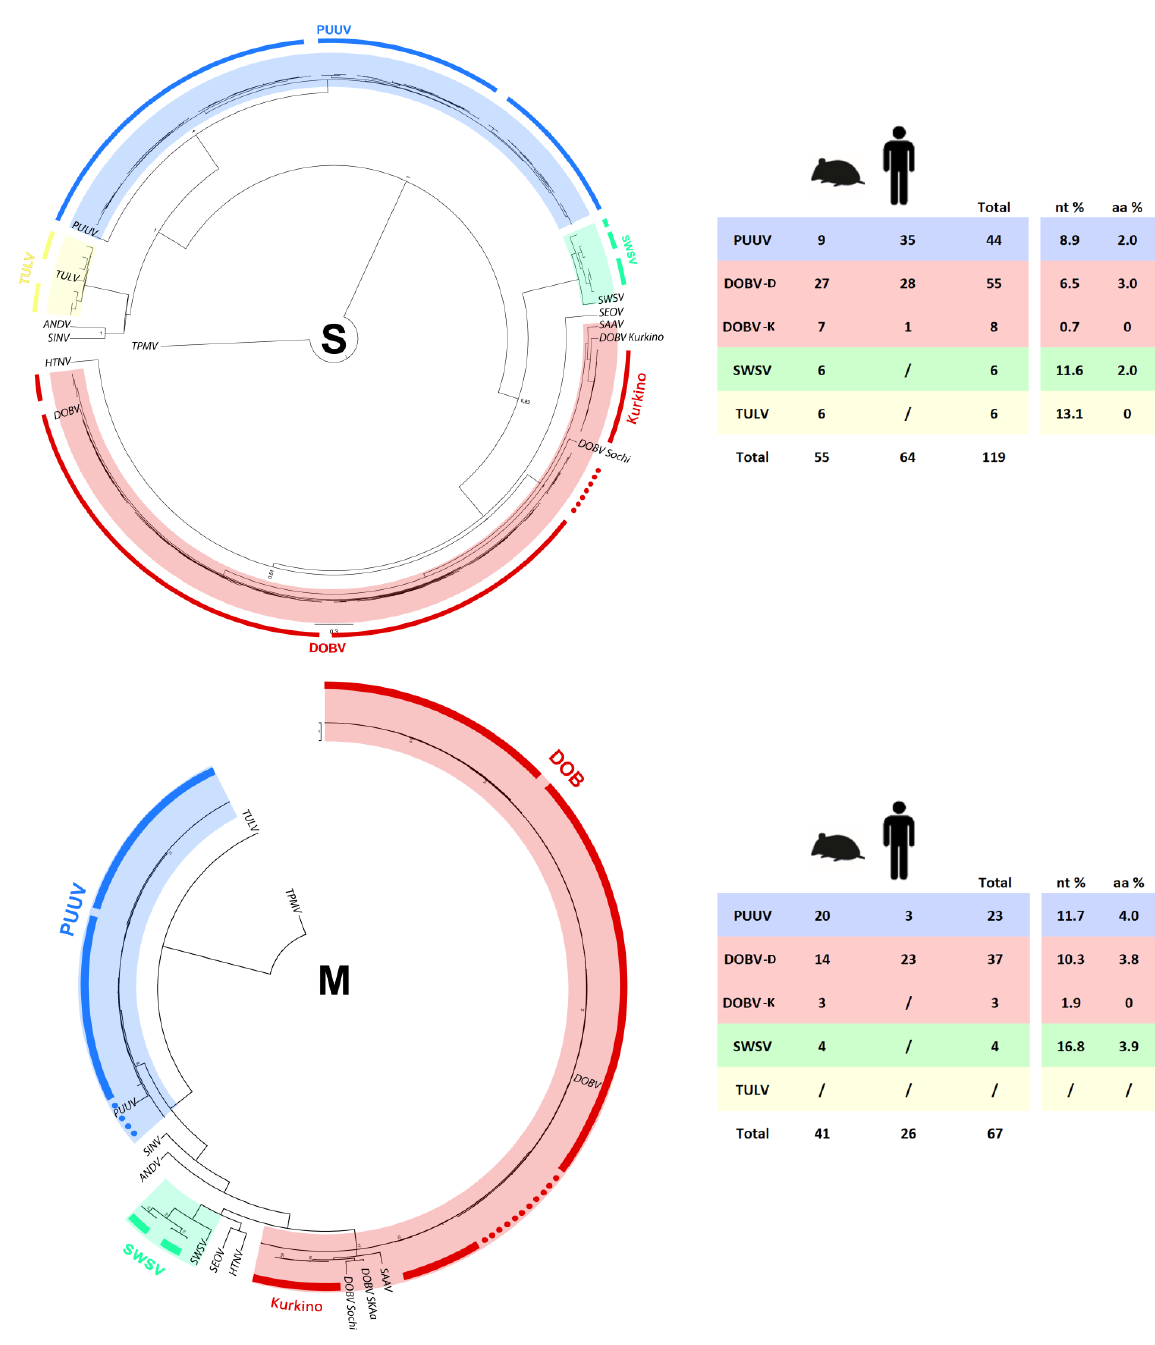
Figure 3. Tree representing bayesian phylogenetic analyses of S segment (306 bp) and M segment (134 bp) of Slovenian hantavirus genotypes, under the best-fit HYK + G model of evolution, four MCMC runs of 10,000,000 generations. The table shows the number of obtained sequences from small mammals and patients, as well as pairwise nucleotide (nt) and deduced amino acid (aa) distances. Dots indicate sequences that could not be assigned to any phylogenetic lineage determined in the L segment